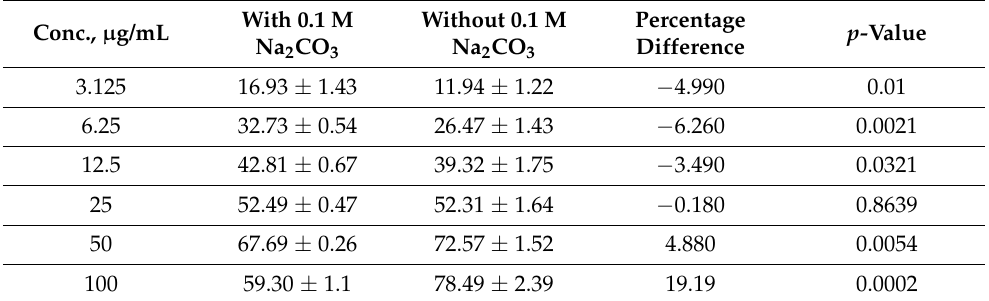
Figure 3. Lineweaver–Burk inhibition plot of α -glucosidase enzyme activity using D. caucasica tuber extract and different concentrations of p NPG (0, 0.004, 0.005, 0.008, 0.01, 0.02 and 0.33 mM). The signs and symbols on the graphic refers: squares: none inhibitor, rhombuses: 200 µg/mL of tubers extract concentration; triangles: 500 µg/mL of tubers extract concentration, [I]: inhibitor/extract; [S]: substrate. The values are the means ± SD ( n = 3).